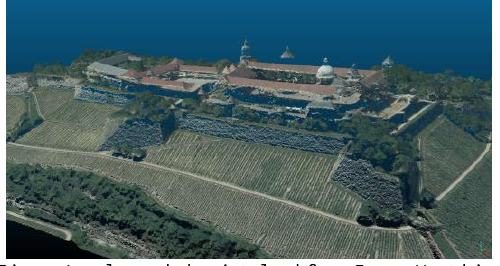
Figure 4. color-coded point cloud from Image Matching In Bavaria the point density of current LiDAR- campaigns is 4 points per square meter. With Image Matching it is possible to square meter due to the ground pixel size of 0.2m of the Bavarian Photogrammetry